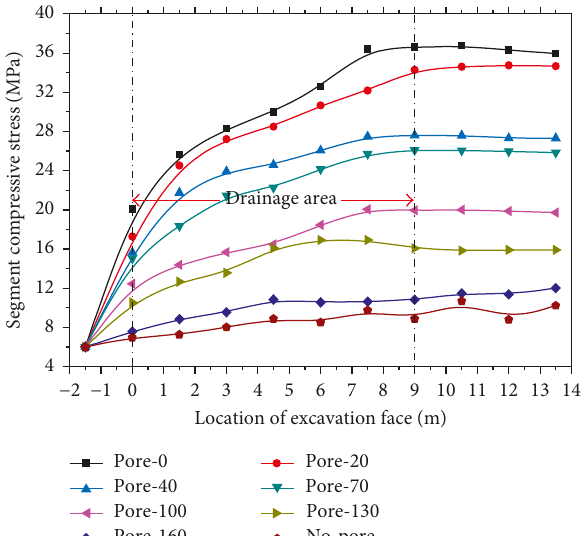
Figure 16: Maximum compressive stress at segment.